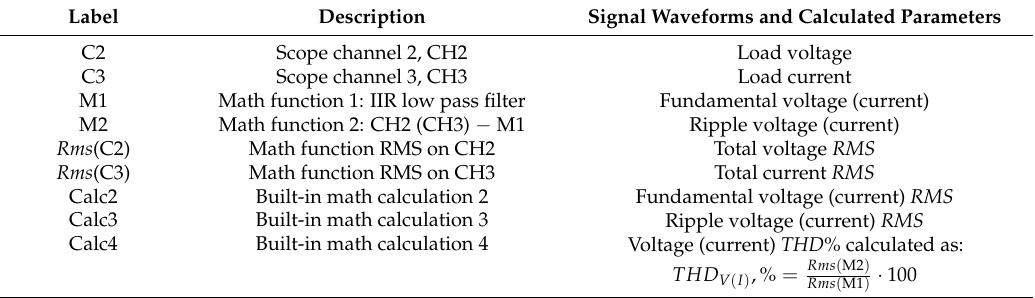
Table 1. Waveforms’ parameters calculated by the scope built-in advanced mathematical functions. RMS: root mean square.